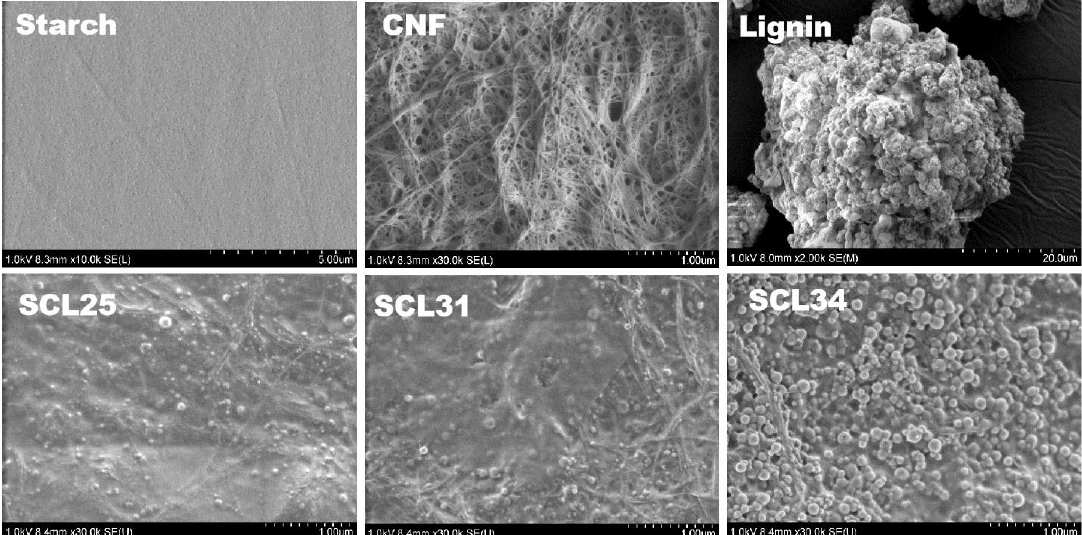
Figure 4. SEM images of neat films and composite films made of starch, CNF and lignin.